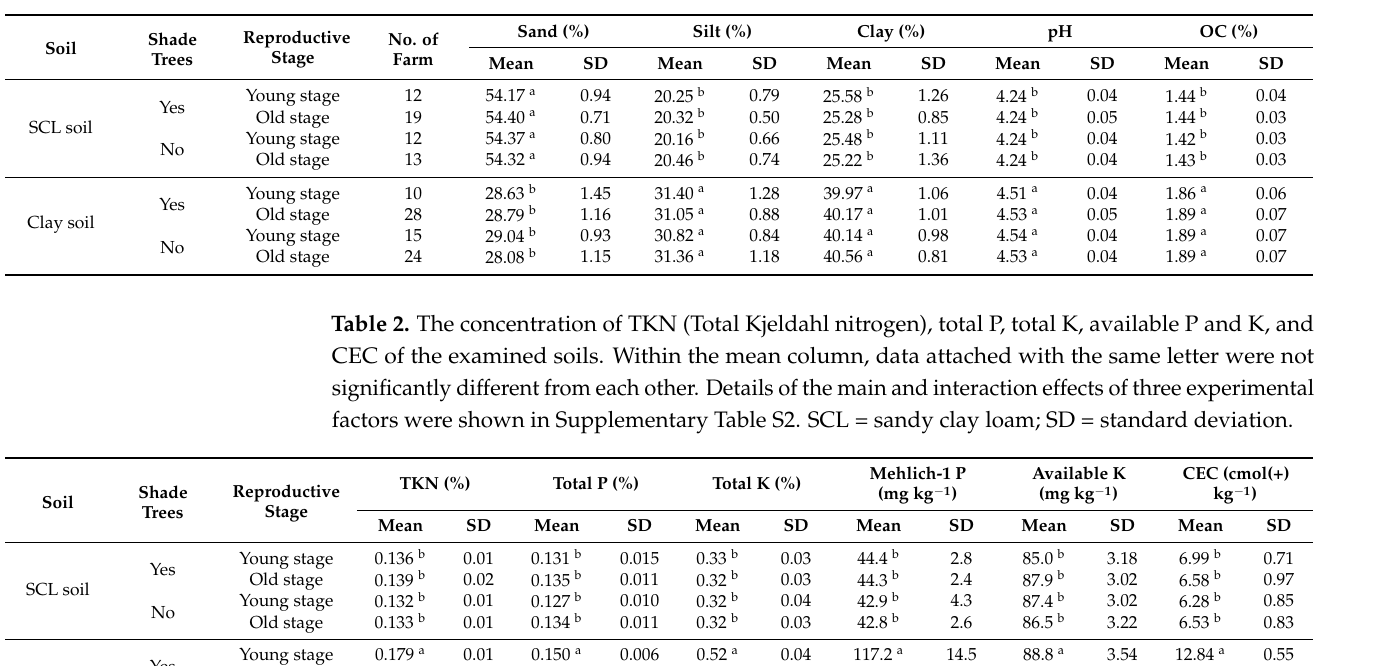
Table 1. The number of coffee farms, the values of sand, silt, clay, pH, and OC (organic carbon) of the examined soils. Within the mean column, data attached with the same letter were not significantly different from each other. Details of the main and interaction effects of three experimental factors were shown in Supplementary Table S1. SCL = sandy clay loam; SD = standard deviation.